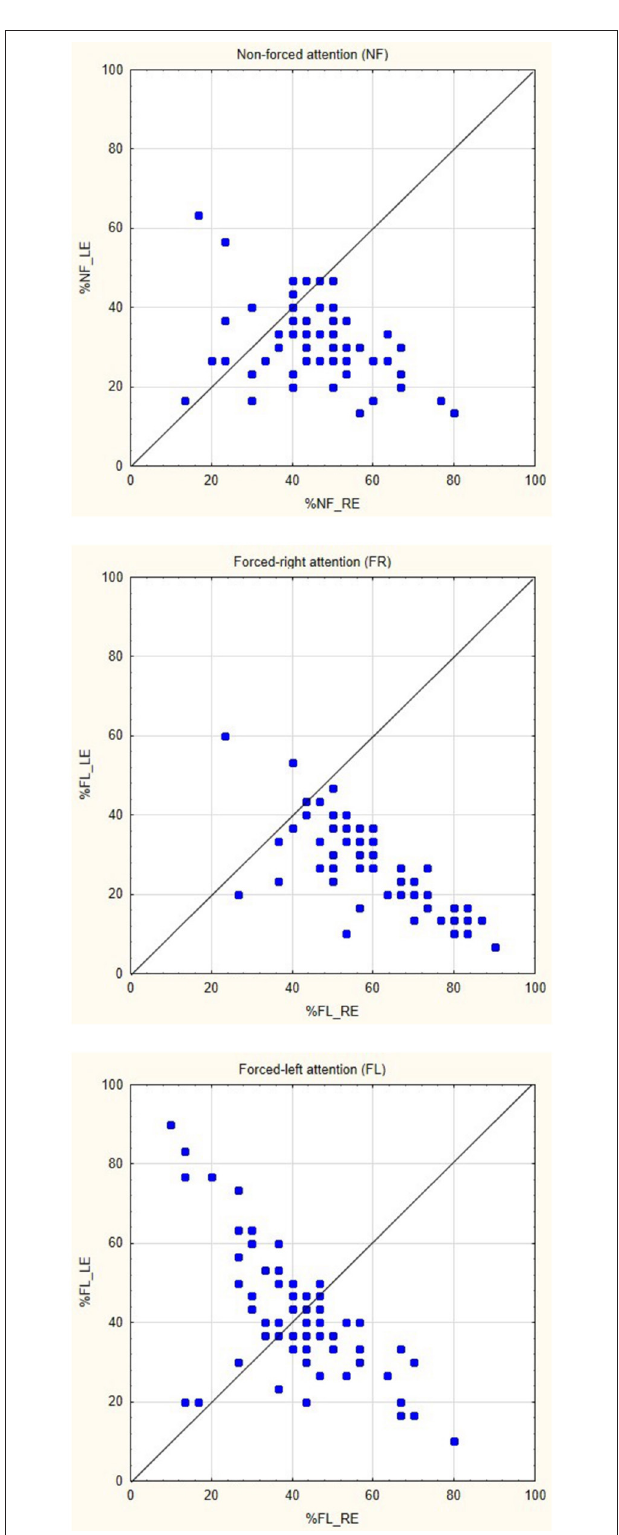
FIGURE 1 | Scatter-plots of individual percentage scores (0–100) for the right (RE) and left (LE) ear scores, split for the three attention instruction conditions non-forced (NF), forced-right (FR), and forced-left